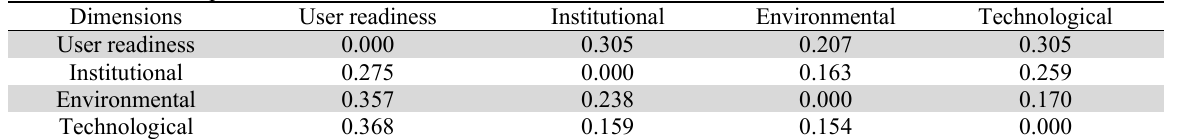
The direct relationship matrix Dimensions